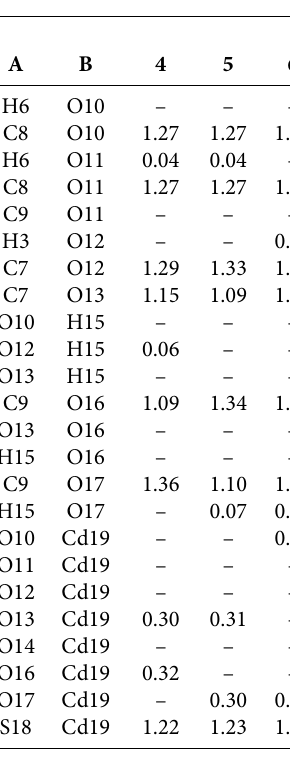
Table 4. Delocalization Indices of structures